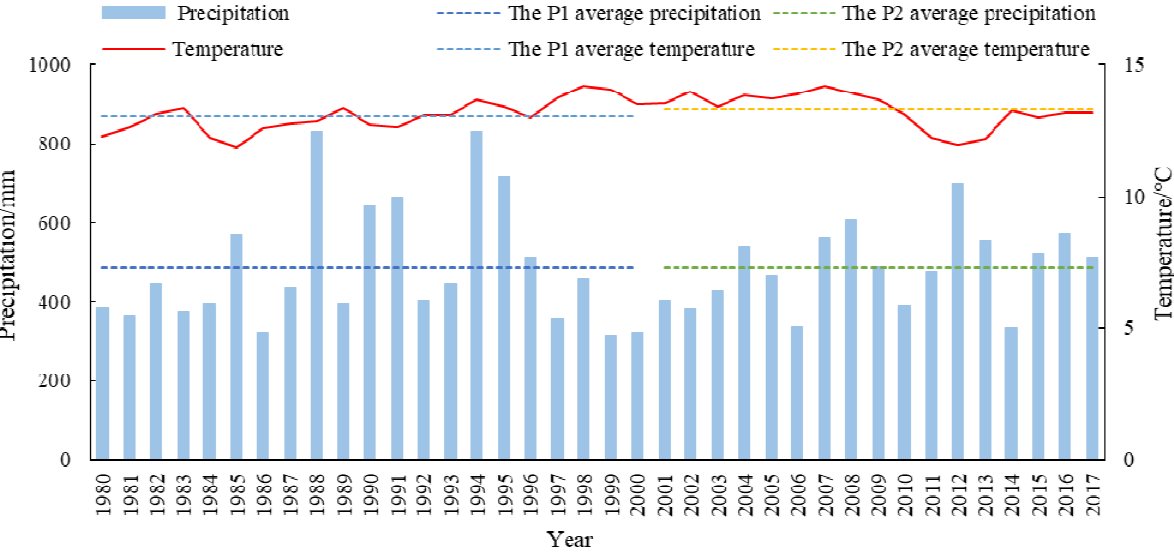
Figure 8. Changes in the precipitation and annual mean temperature in the Xiong’an New Area from 1980 to 2017. The data source: http://data.cma.cn/ (accessed on 10 October 2020).